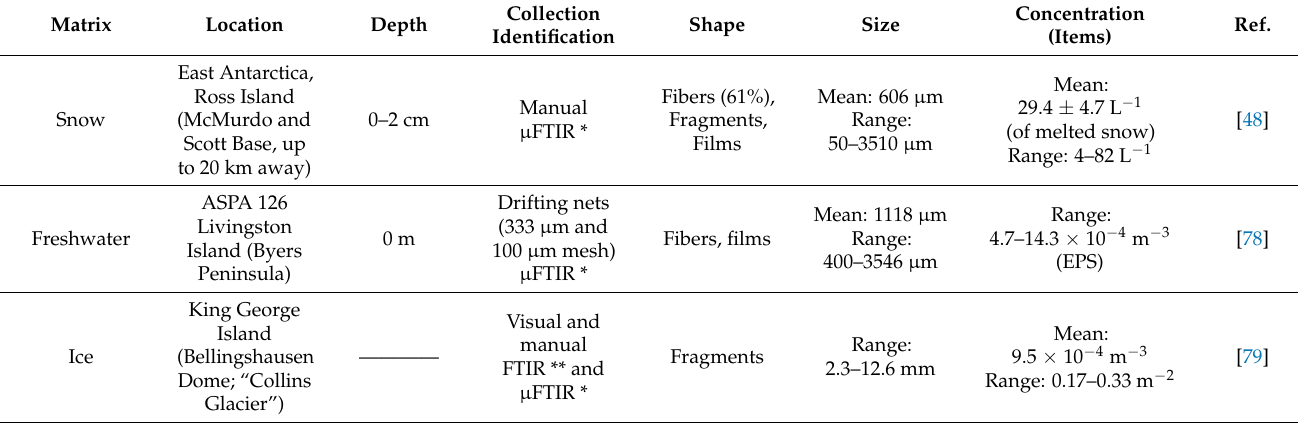
Table 1. Microplastics in Antarctic environmental abiotic